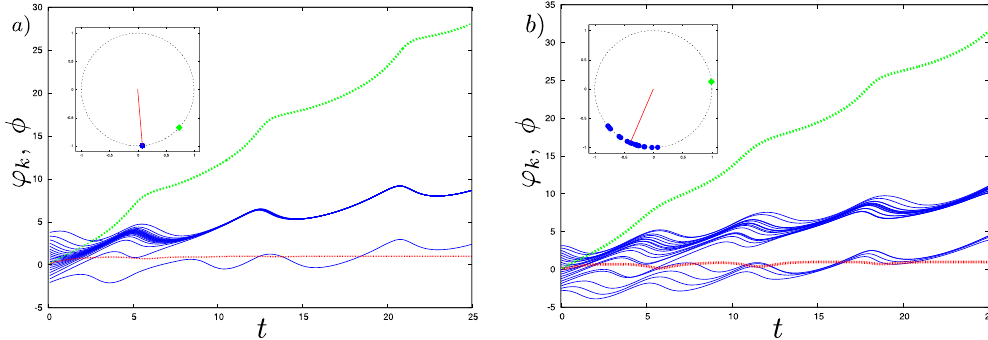
Figure 2. Simulation of the system (2) for N = 20 oscillators with the parameters A = B = 1, α β π = = . 0 3 and ω = . 1 4 . In panel a) the natural frequencies of the oscillators are identical and set to 0; in panel b) ω i are 0 randomly chosen from the Gaussian distribution with the zero mean and the standard deviation 0.1. Time- dependence of the phase of the leader φ t ( ) (dashed green line), the phases ϕ t ( ) and their order parameter (dotted red line). Note that the difference between the blue branches is exactly 2 π . (Insets) Snapshots of the oscillators. The leaves are represented as blue circles and the leader as a green diamond; the red line is the order parameter of the